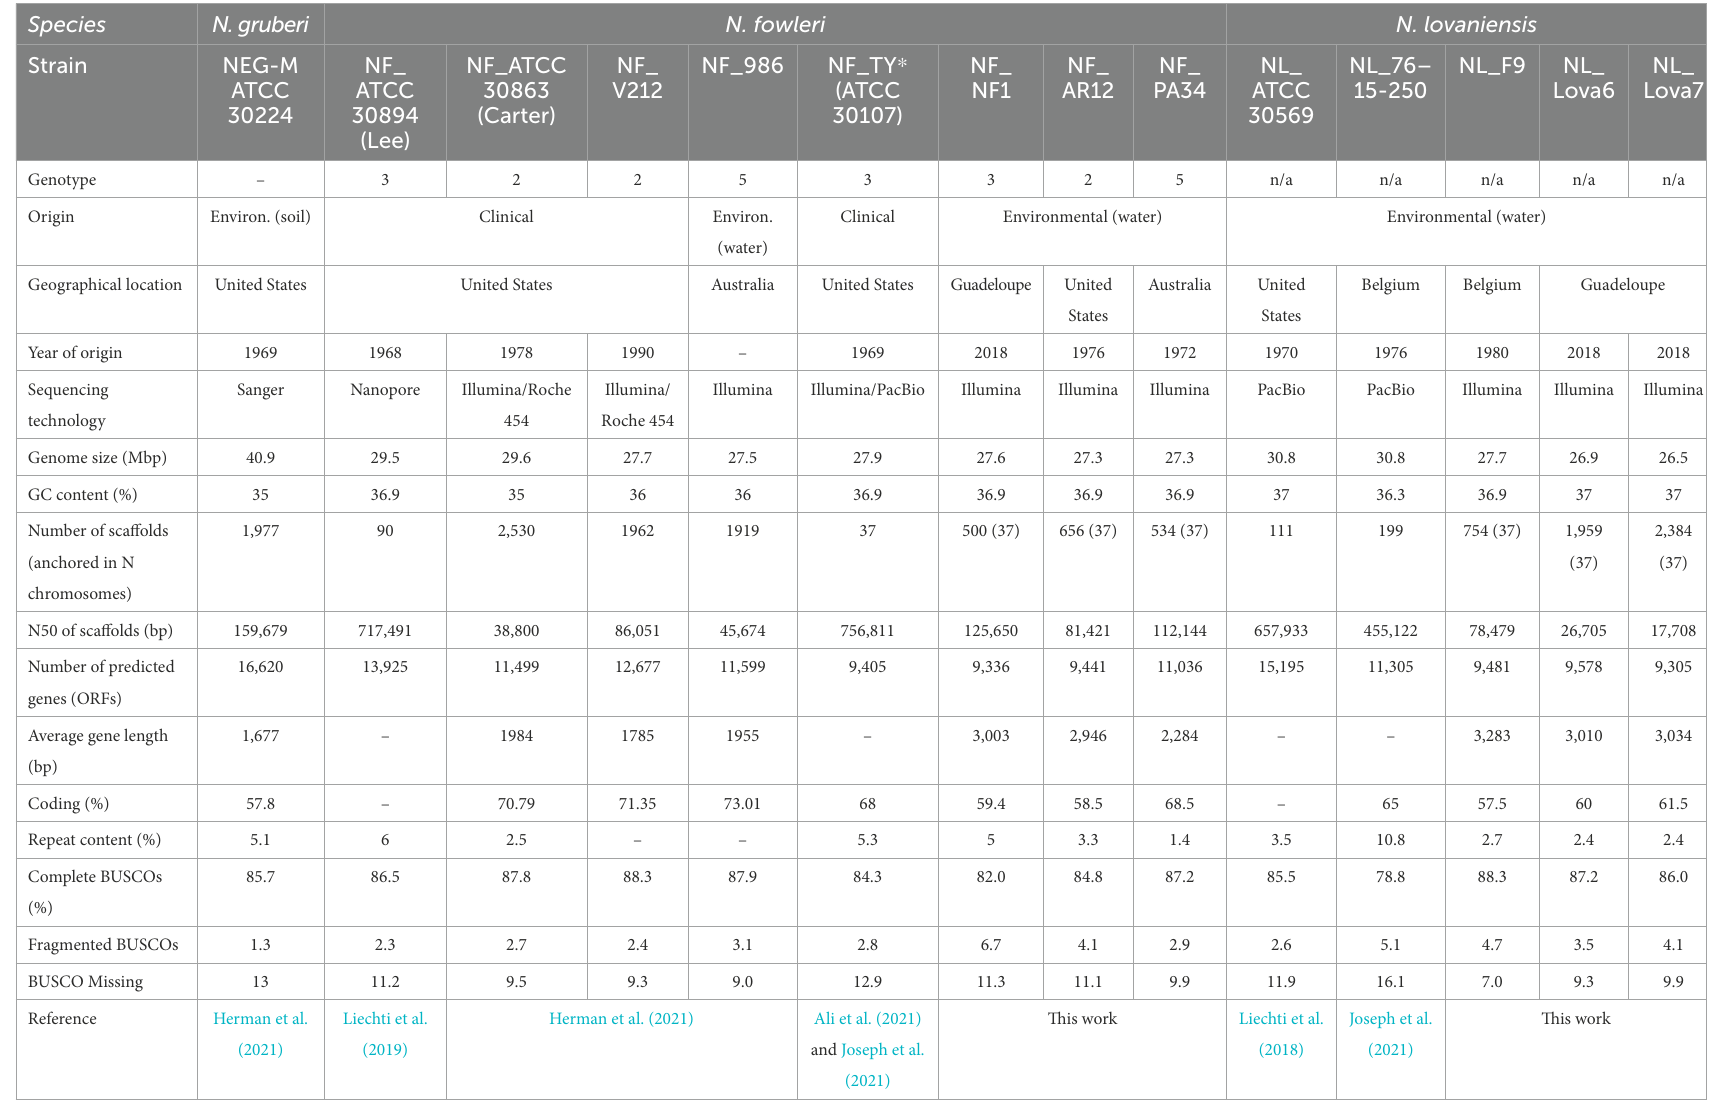
TABLE 1 Genome assemble and annotation statistics of published and newly sequenced genomes of Naegleria sp.